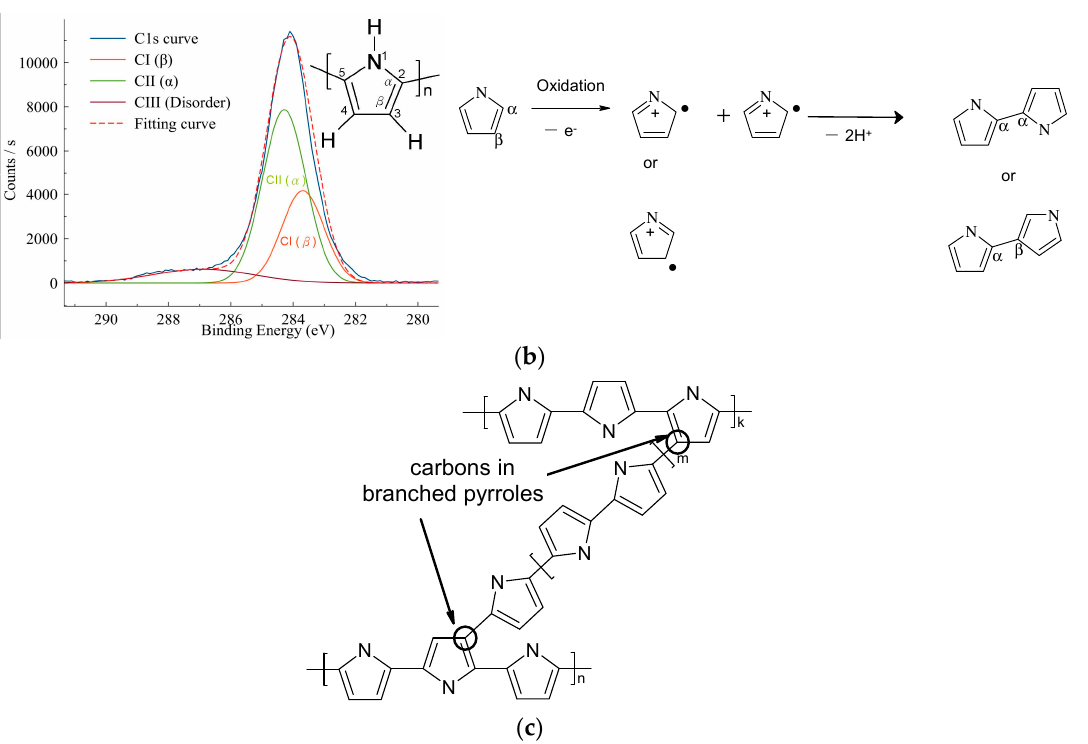
Figure 4. The chemical compositions of PPy films: ( a ) the XPS analysis; ( b ) schematic illustration of the cationic radicals of pyrrole link may each other through the 2,5 position ( α – α ’ linkage) or the 2,3 position ( α – β ’ linkage); and ( c ) the polymerization of pyrrole is mainly through the α – α ’ linkage. However, if α – β ’ linkage branches from the α – α ’ linked main chains to form side chains or inter-chain links, the C1s of β carbons in branched pyrroles is shifted to form a disorder peak.